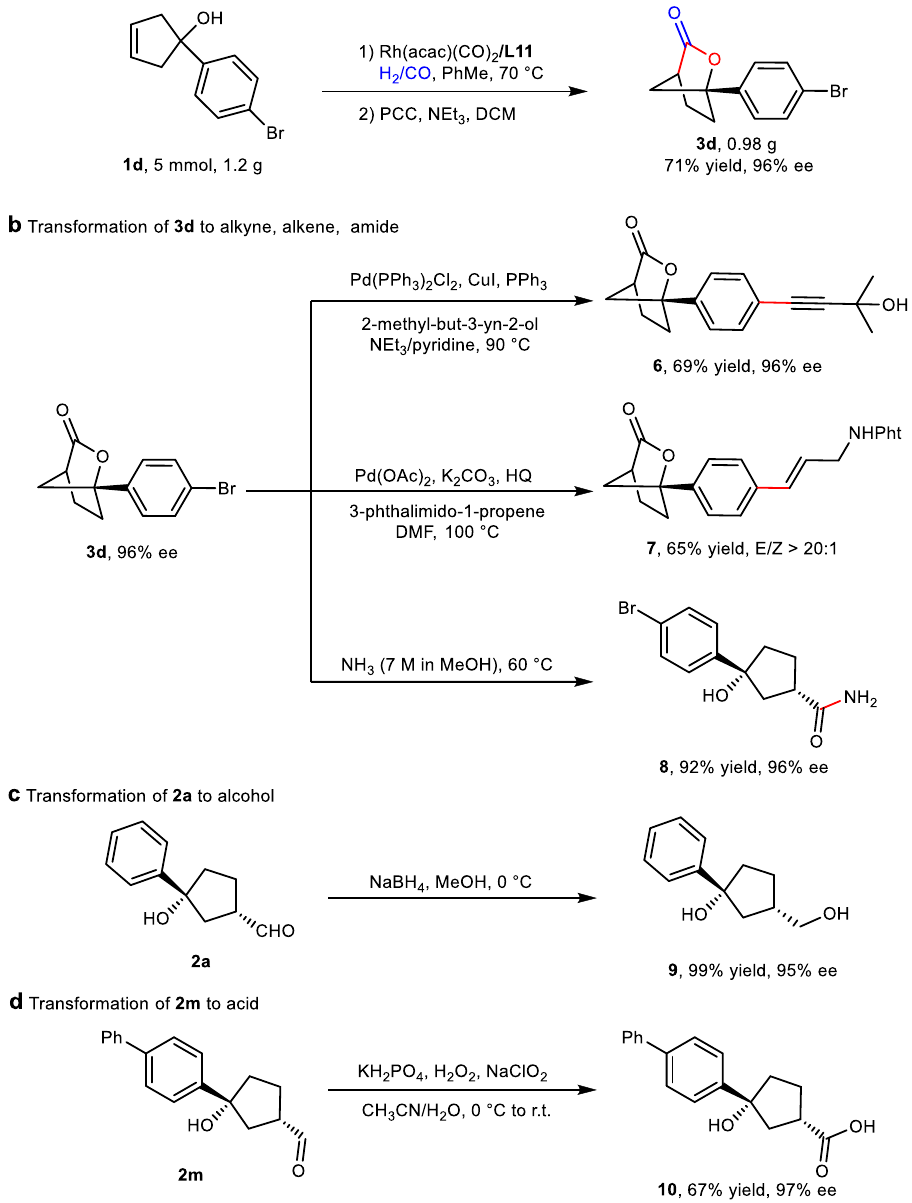
Fig. 6 Gram-scale reaction and transformations of oxo-products and ring-opening reaction of bridged [2,2,1] bicyclic lactones. a Gram-scale reaction. b Transformation of 3d to corresponding alkyne, alkene and amide. c Reduction of 2a to alcohol. d Oxidation of 2m to acid.